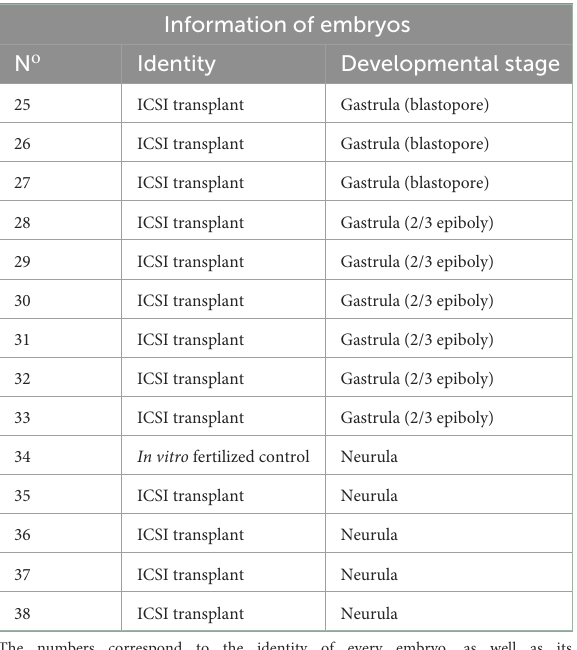
TABLE 5 Information of transplants after ICSI with single cryopreserved beluga spermatozoa into sterlet eggs and one in vitro produced control embryo used for the molecular